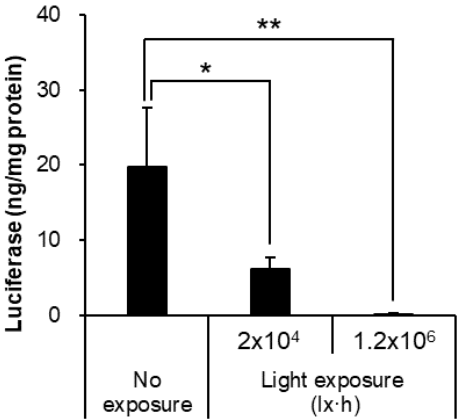
Figure 4. Effects of light exposure for in vitro luciferase assay. The mRNA-LNP exposed to light (2 × 10 4 lx · h, 1.2 × 10 6 lx · h) or not, respectively. Firefly luciferase expression in HepG2 cells was measured at post 24 h adding of each mRNA-LNPs. Data are represented as mean + S.D. ( n = 3). ** p < 0.01, * p < 0.05 indicate significant differences versus no exposure (Dunnett’s test).